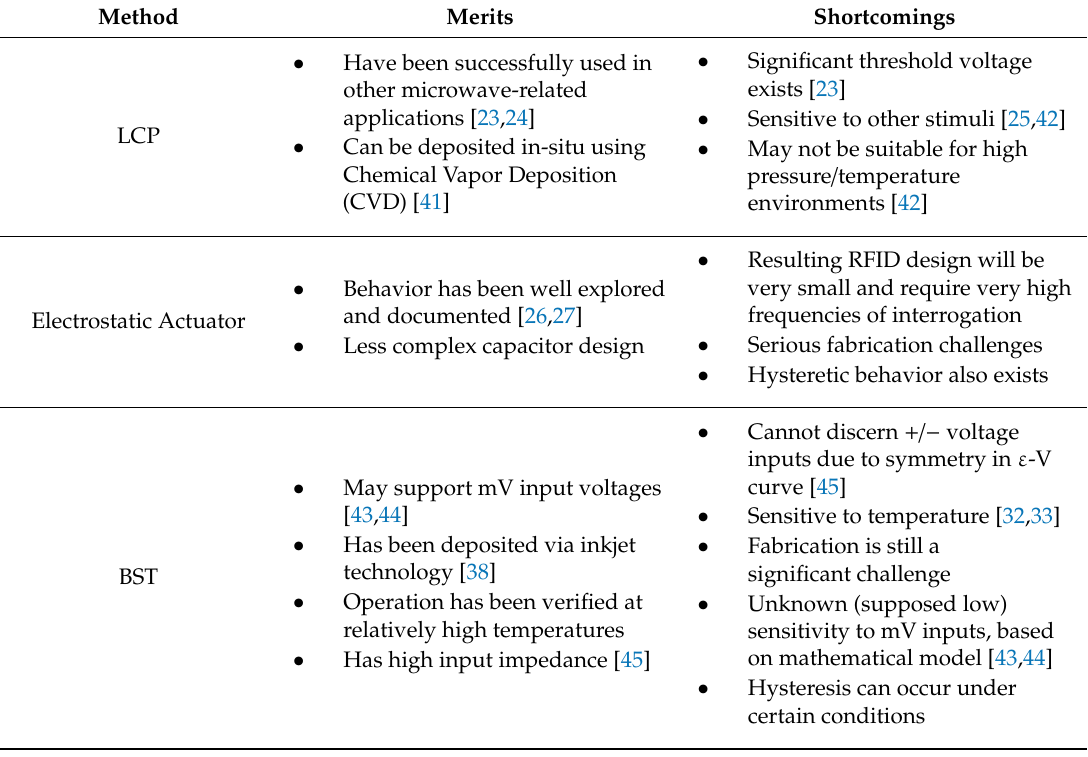
Table 1. Comparative analysis of varactor